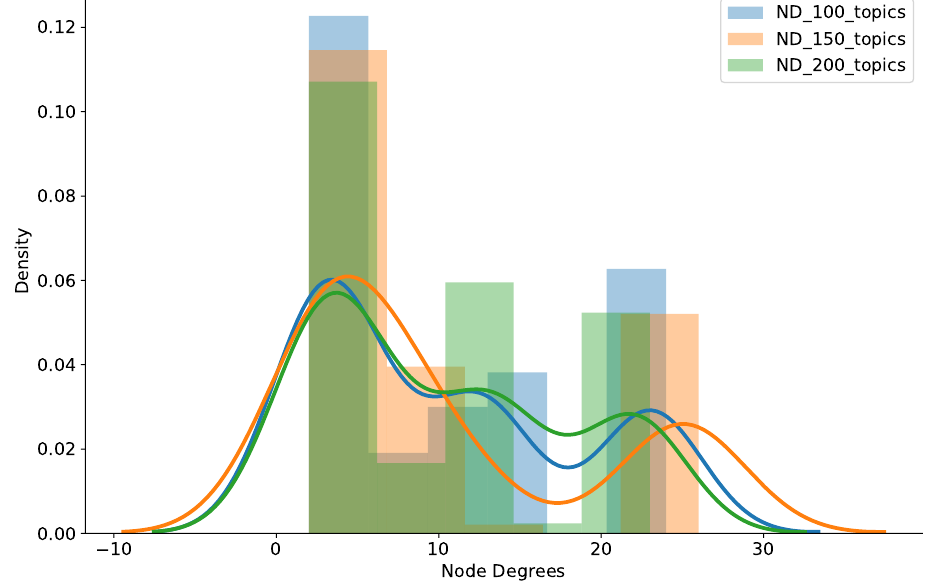
Figure 6. Histogram and density of node degrees from varied numbers of